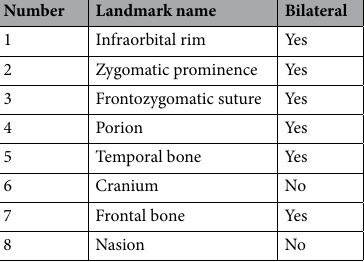
Table 2. Anatomical landmarks positions. The numbers correspond to the numbers in Fig. 1a.